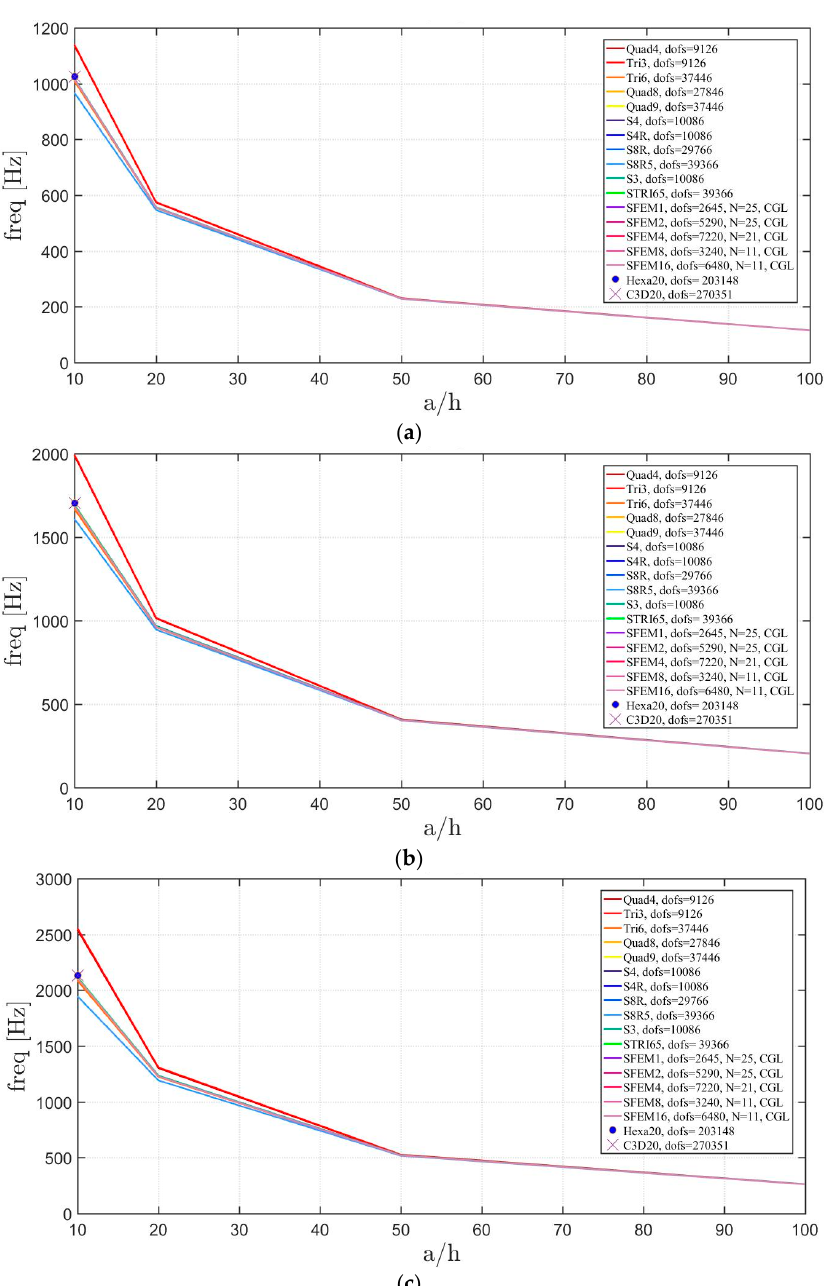
Figure 4. Thickness effect on the first three natural frequencies of an isotropic skew plate of 30°: ( a ) First frequency; ( b ) Second frequency; ( c ) Third frequency.